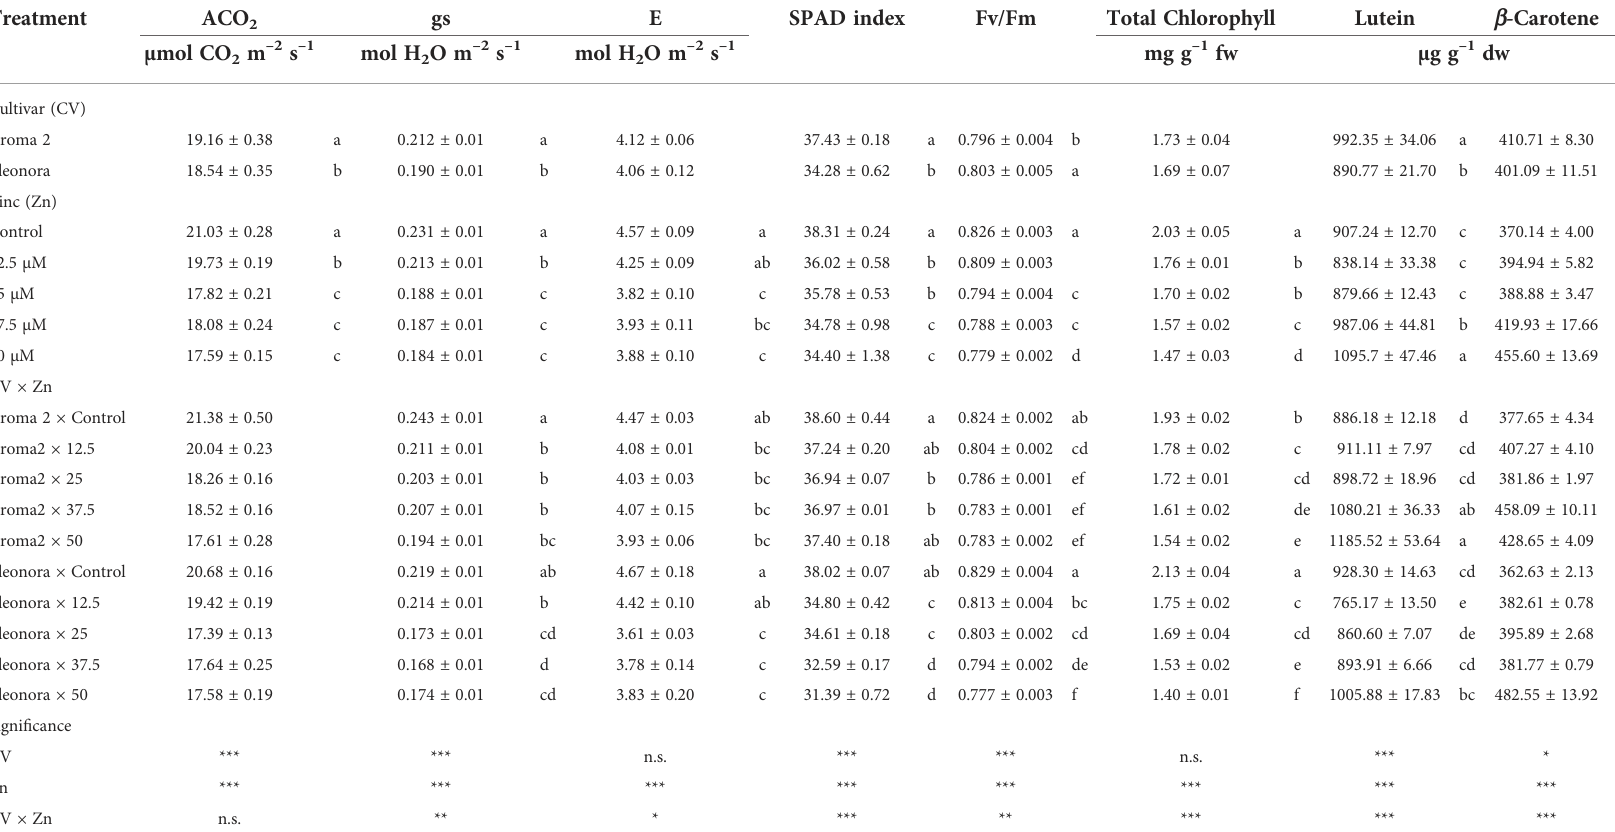
TABLE 3 Analysis of variance and mean comparisons for net CO 2 assimilation rate (ACO 2 ), stomatal conductance (gs ) , transpiration (E), SPAD index, Fv/Fm, total chlorophyll, and carotenoids of Aroma 2 and Eleonora basil cultivars grown hydroponically under different Zn treatments: 0 = Control; 12.5; 25; 37.5; 50 µmol of